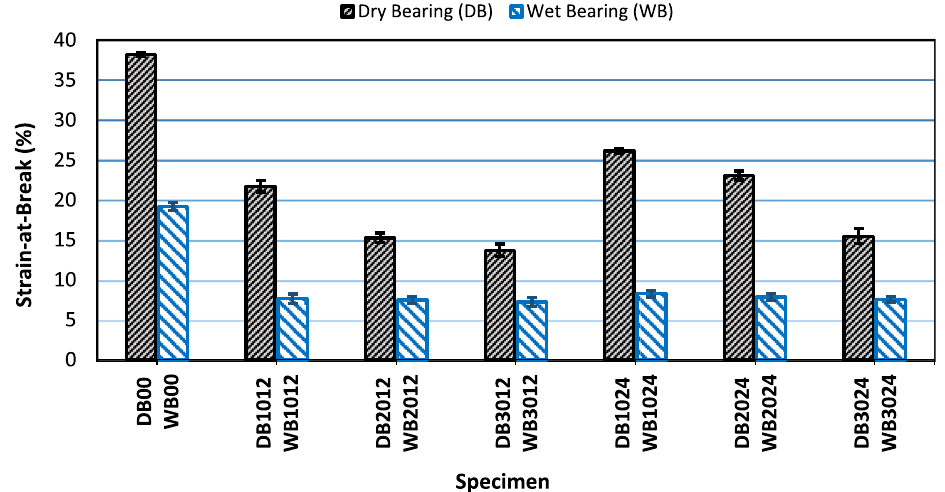
Figure 8. Strain-at-break for dry and wet specimens tested in bearing.